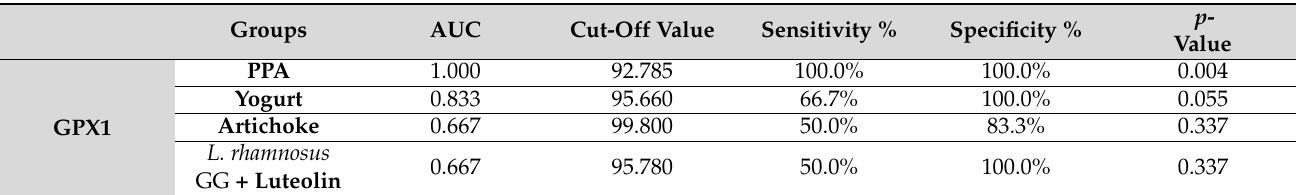
Table 3. ROC results of GPX, GSH, and GABA in the tissue homogenates of the PPA-induced rodent model of autism and yogurt, artichoke, and combined L. rhamnosus GG + luteolin nutritionally treated groups relative to the control